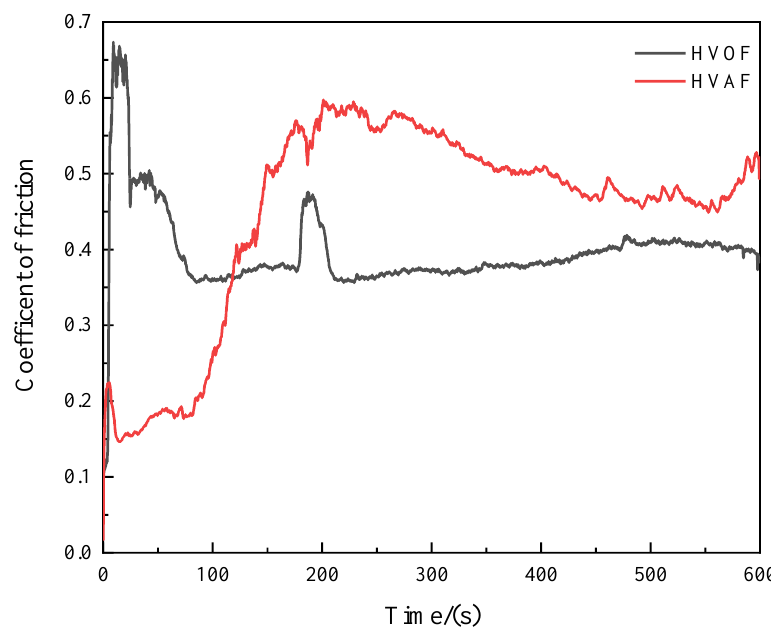
Figure 8. Friction coefficient curve of Stellite 20 coating deposited by HVAF and HVOF.